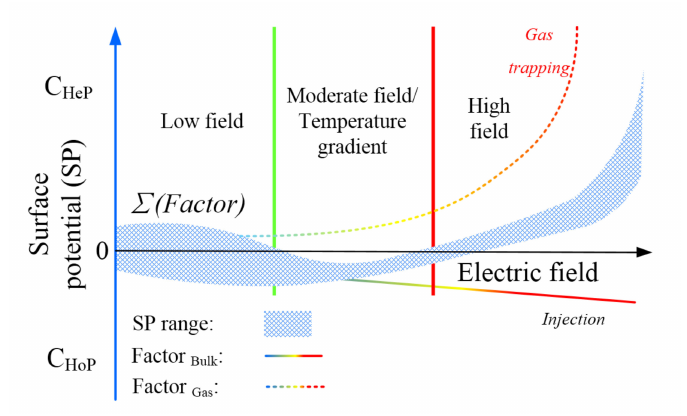
Figure 2. Field-dependent model of dominant charge behavior